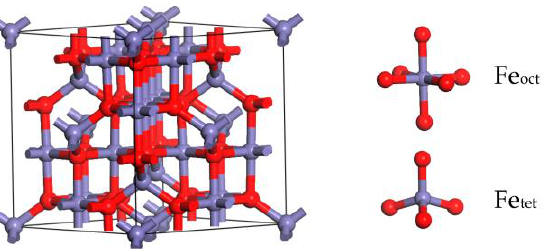
Figure 12. The unit cell of γ -Fe 2 O 3 , showing the Fe cations (in purple) and oxygen ions (in red). The γ -Fe 2 O 3 (001) and γ -Fe 2 O 3 (111) surfaces are the most widespread surfaces that